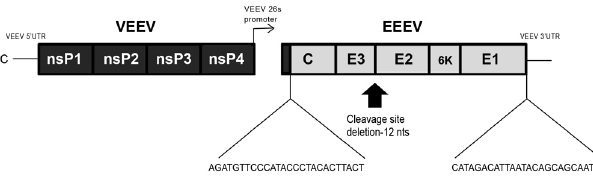
Figure 1. Schematic of the pCVEV1219 plasmid. The 5 9 - and 3 9 -UTR, nonstructural proteins, 26S and a portion of the capsid protein was derived from the V3000 cDNA clone. The remainder of the capsid protein through the E1 glycoprotein stop codon was derived from the EEEV FL91-4679 cDNA clone. In addition, the site for furin cleavage was deleted; therefore, furin is unable to cleave E2 and E3 and they are transported to the cell surface as their precursor